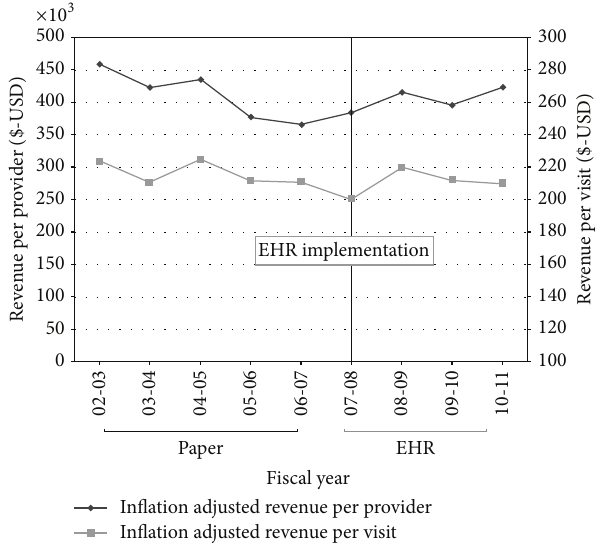
Figure 1: University of California, Davis Eye Center Revenue